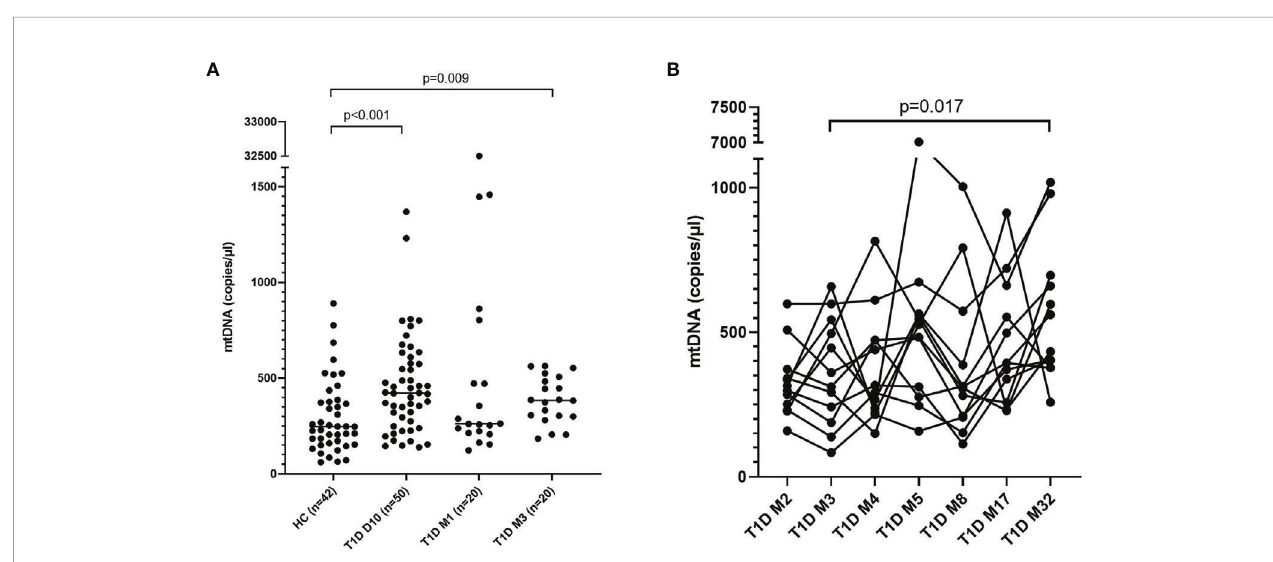
FIGURE 3 | Levels of mtDNA in children with newly diagnosed type 1 diabetes (T1D). Healthy children (n=42) compared with children after onset of T1D; 10 days (n=50), 1 month (n=20) and 3 months (n=20) after onset (cohort 1, Mann-Whitney test) (A) . Levels of mtDNA over time in paired samples from T1D children (n=12) in cohort 2 (Friedman ’ s test followed by Dunn ’ s multiple comparisons test) (B)